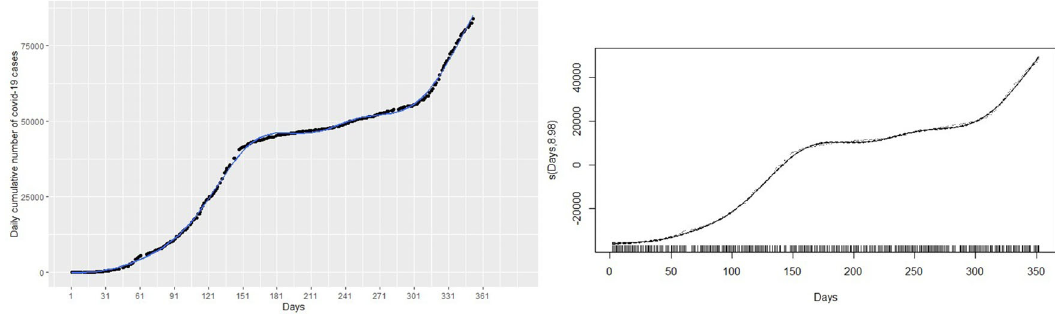
Figure5.Fitofthegeneralizedadditivemodel(leftpanel)withtheeffectoftime(days)estimatedasasmooth curve with 8.98 degrees of freedom and a plot of days versus partial residuals (right